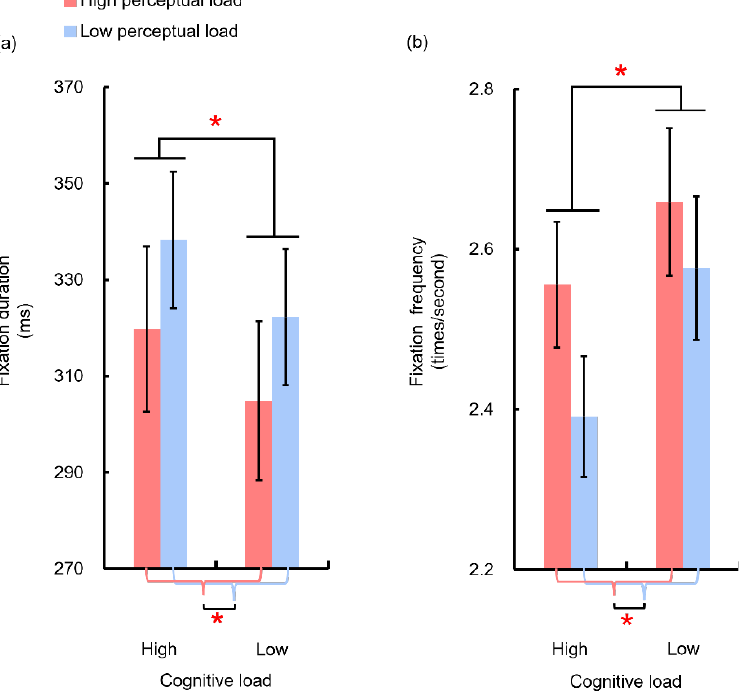
Figure 8. Perceptual load and cognitive load had an opposite effect on fixation duration and fixation frequency. ( a ) Higher perceptual load led to decreased fixation durations but higher cognitive load led to increased fixation durations. ( b ) Higher perceptual load led to increased fixation frequencies but higher cognitive load led to decreased fixation frequencies. The curly brackets and the asterisk at the bottom of each graph indicate the main effect of the perceptual load where the red and blue curly brackets indicate the mean value of the two red lines and the two blue lines, respectively, and the asterisk at the bottom refers to a significant difference between these two mean values. Error bars refer to one standard error from the mean. * p < 0.05.